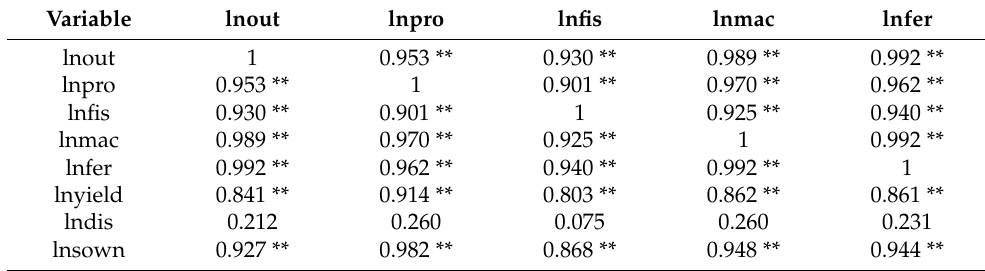
Figure 5. Comparative advantage of Xinjiang cotton production from 2005–2018. Table 2. Pearson Correlation Analysis.